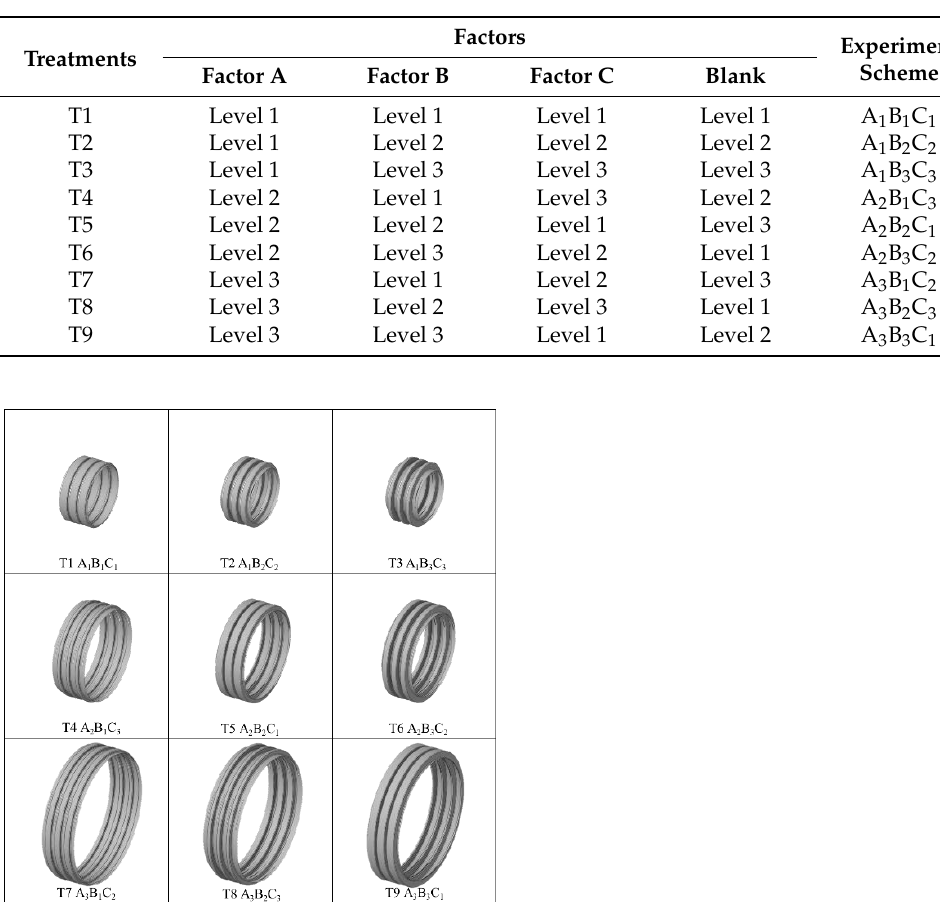
Table 4. Orthogonal test design table (L 9 (3 4 )).